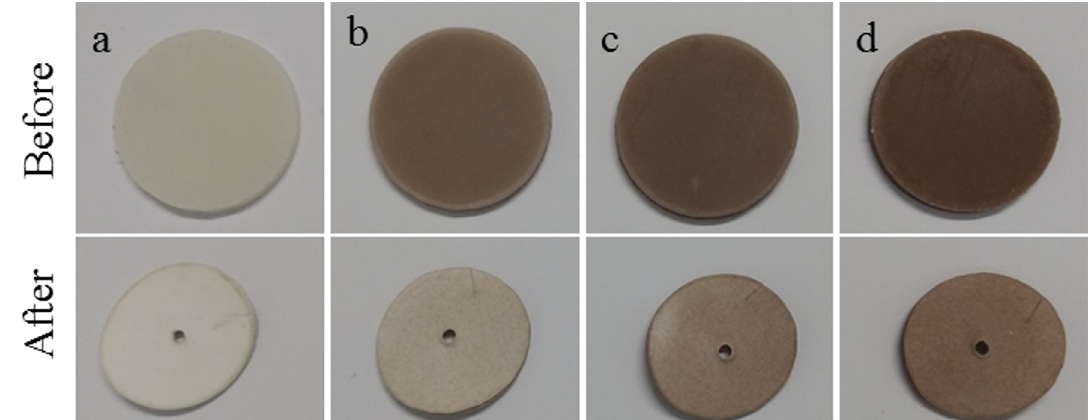
Figure 6. Images of the compounds before and after SEBS phase extraction. (a) 0% CuMP, (b) 1% CuMP, (c) 2% CuMP, (d) 4% CuMP